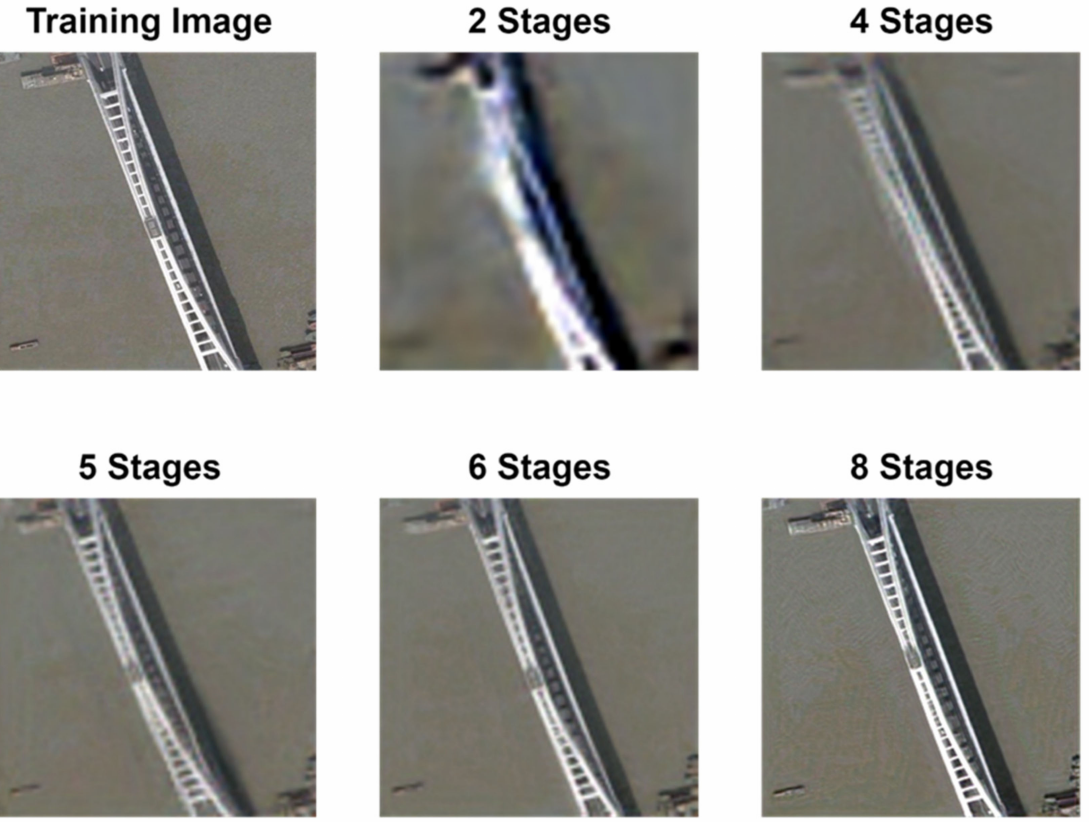
Figure 8. Effect of training with different stages by the improved